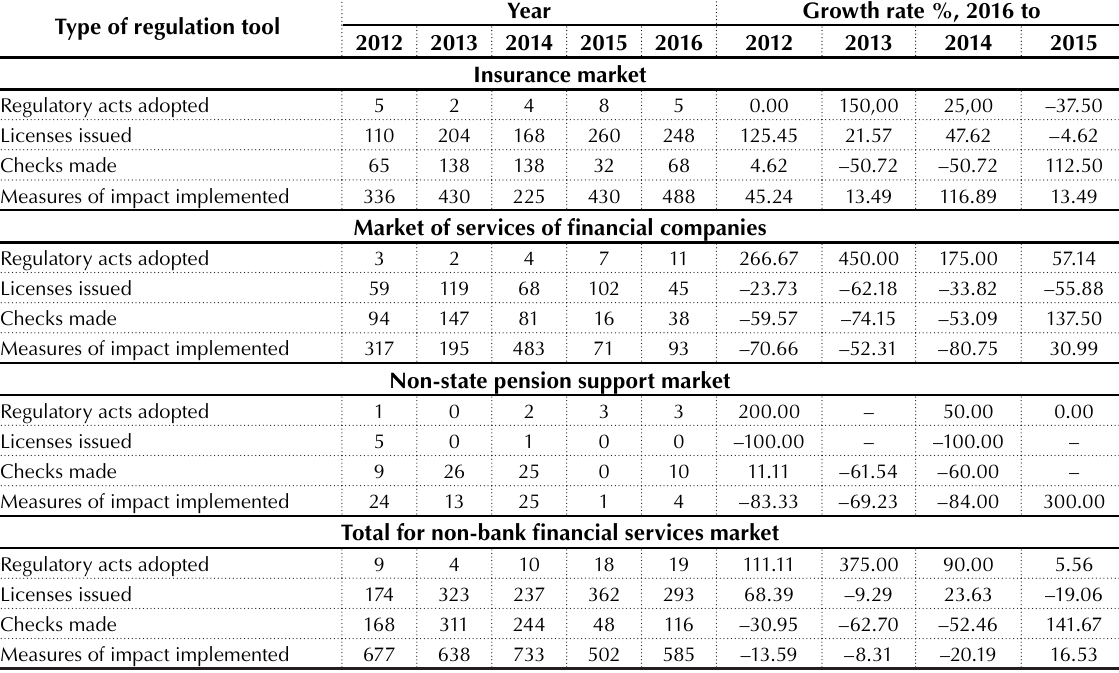
Table 2. Application of instruments of the mechanism for state regulation of the financial